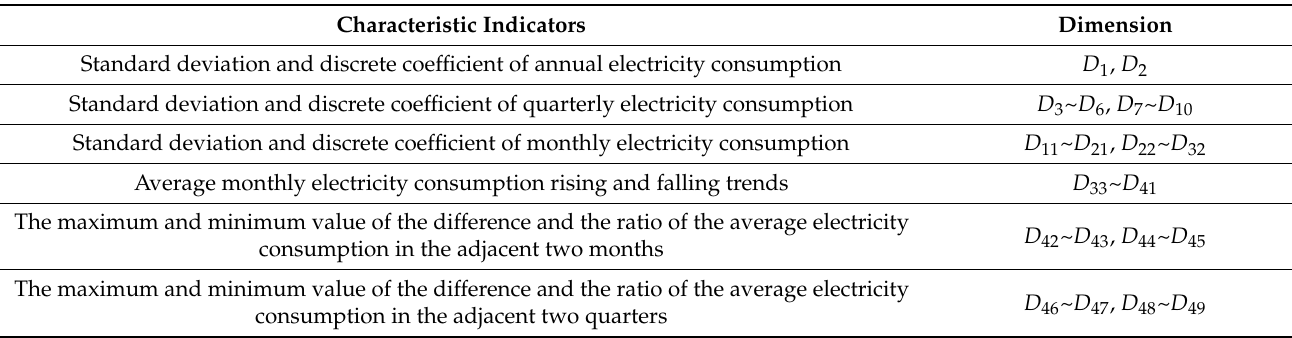
Table 2. The characteristic indicators of user electricity consumption time series statistical. Characteristic